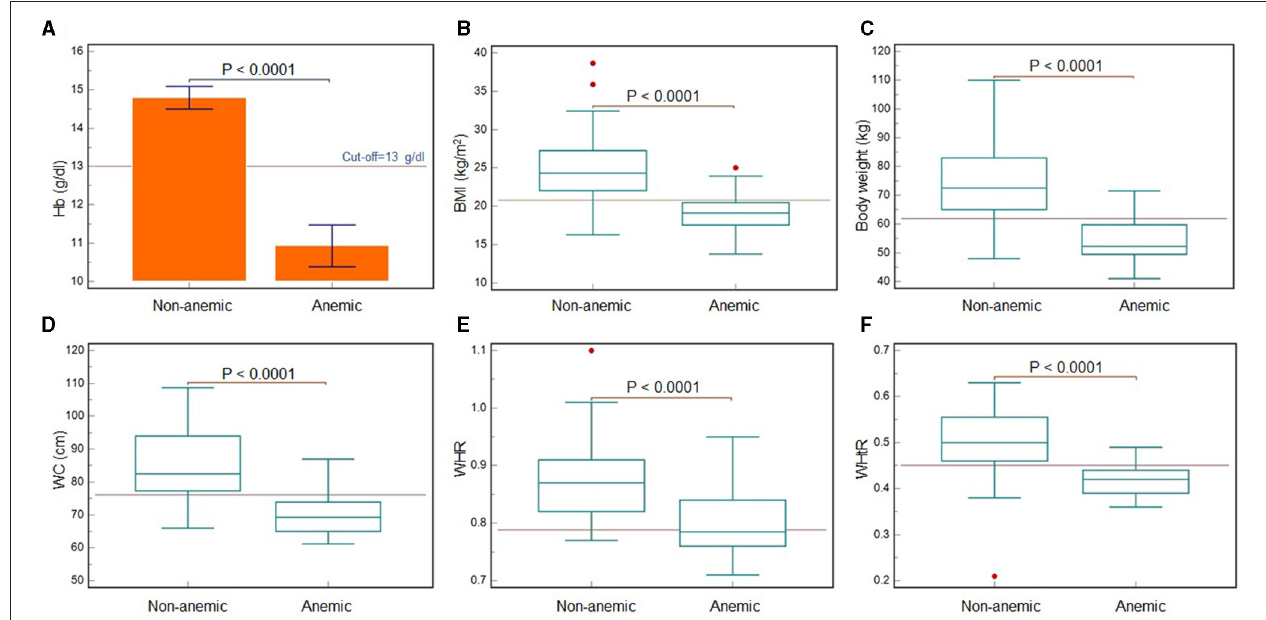
FIGURE 2 | Comparison of hemoglogin levels (A) and anthropometric variables (B–F) between Malaysian young adult men with and without anemia. Statistically significant differences ( P < 0.0001) were recorded for hemoglobin concentration (A) , BMI (B) , body weight (C) , WC (D) , WHR (E) and WHtR (F) . The red lines are indicating the cut-off values. Hemoglobin cut-off is as per the WHO reference standard (WHO, 2011).